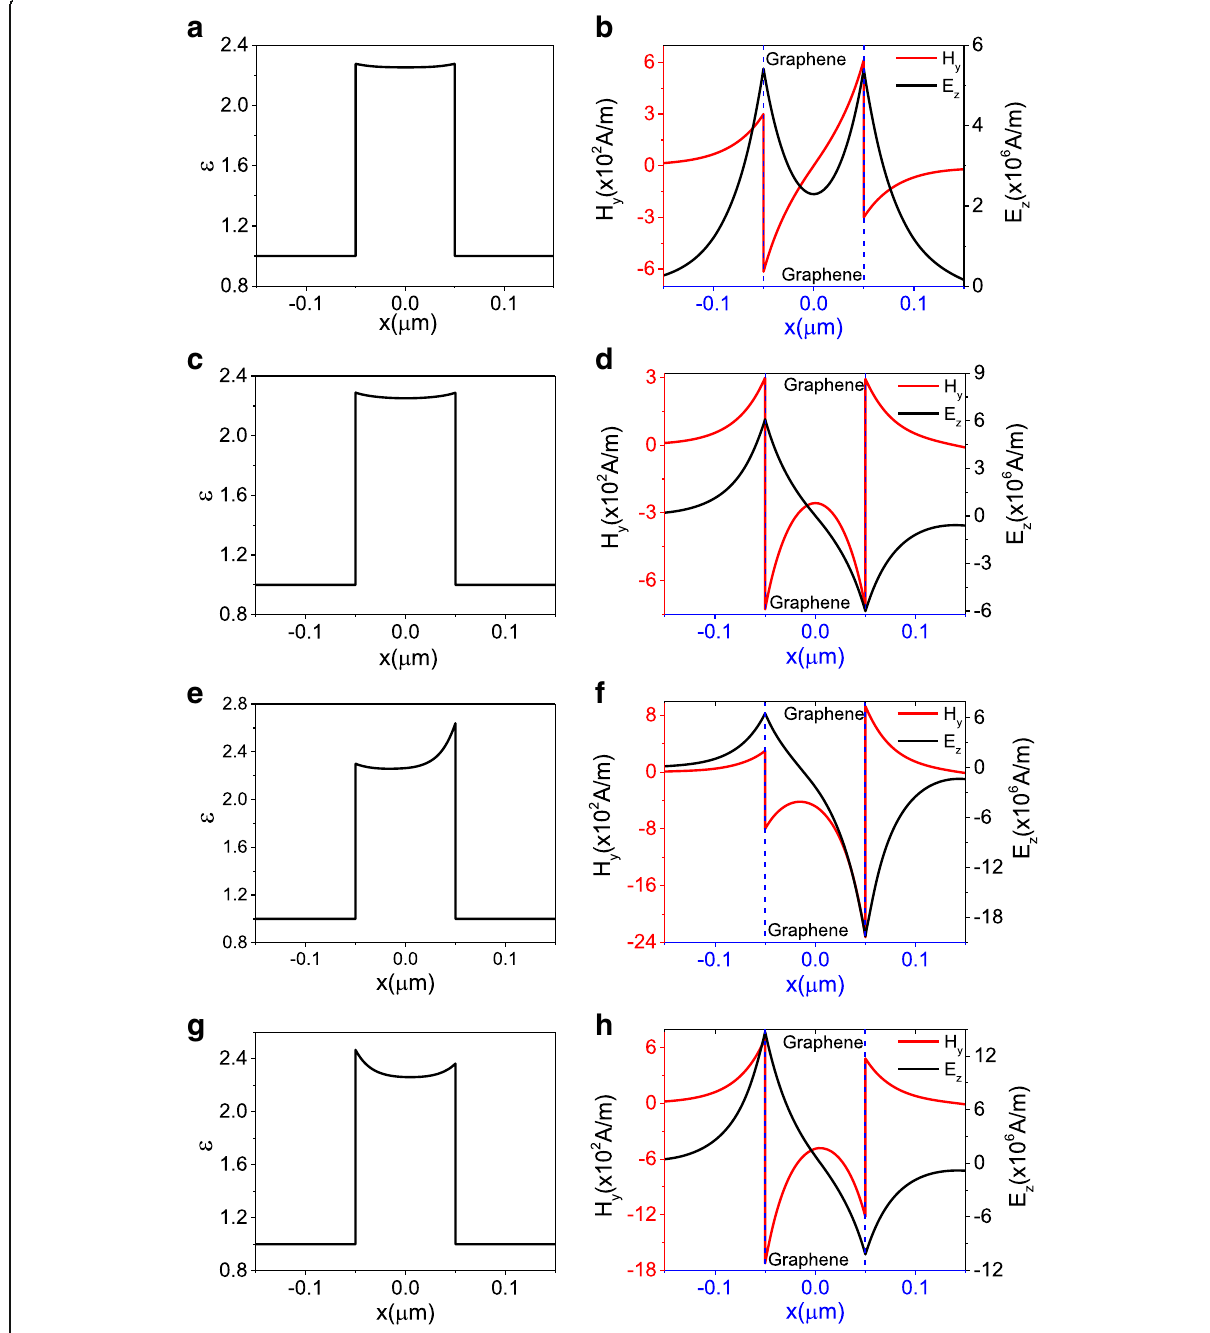
Fig. 3 The permittivity and modes distribution for magnetic component H y and electric component E z . a and b correspond the point A ( H 0 = 300, β = 6.94 × 10 − 2 k F ) marked in Fig. 2 for symmetric modes, c and d correspond the point B ( H 0 = 300, β = 7.81 × 10 − 2 k F ) marked in Fig.2 for antisymmetric modes, e and f correspond the point C ( H 0 = 300, β = 8.36 × 10 − 2 k F ) marked in Fig. 2 for asymmetric modes, and g and h correspond the point D ( H 0 = 700, β = 8.07 × 10 − 2 k F